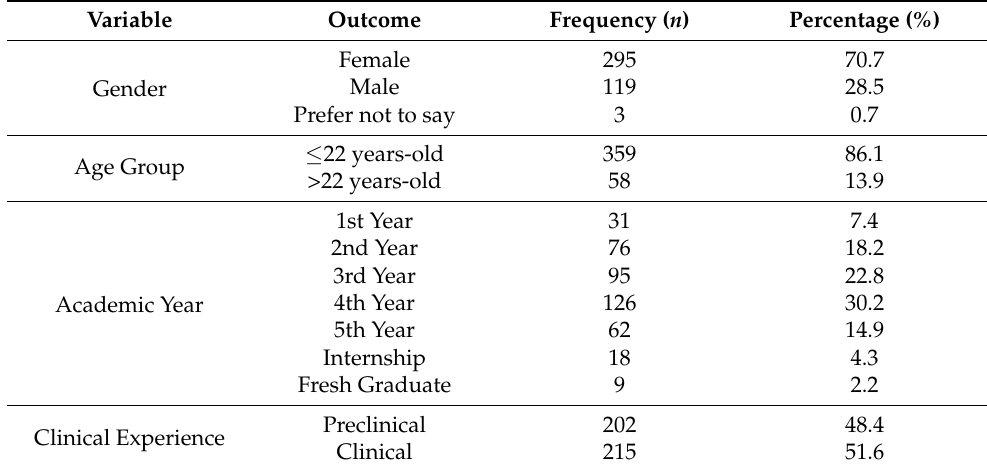
Table 1. Demographic characteristics of Palestinian dental students, February–March 2021 ( n = 417).